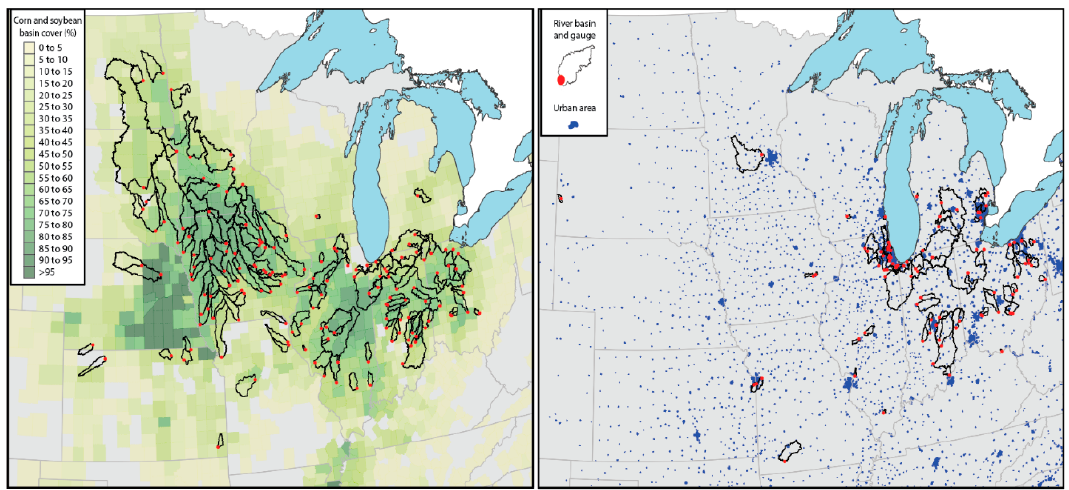
Figure 2. Location of agricultural and urban drainage basins. Gauging stations are indicated as red circles, and contributing drainage basins as black outlines: ( Left ) percent of the basin that is planted as corn and soybean in 2014, ranging from yellow (0–5%) to dark green (>95%); ( Right ) urban areas (blue) and urban drainage basins (with a population density of more than 50 persons/km 2 ).